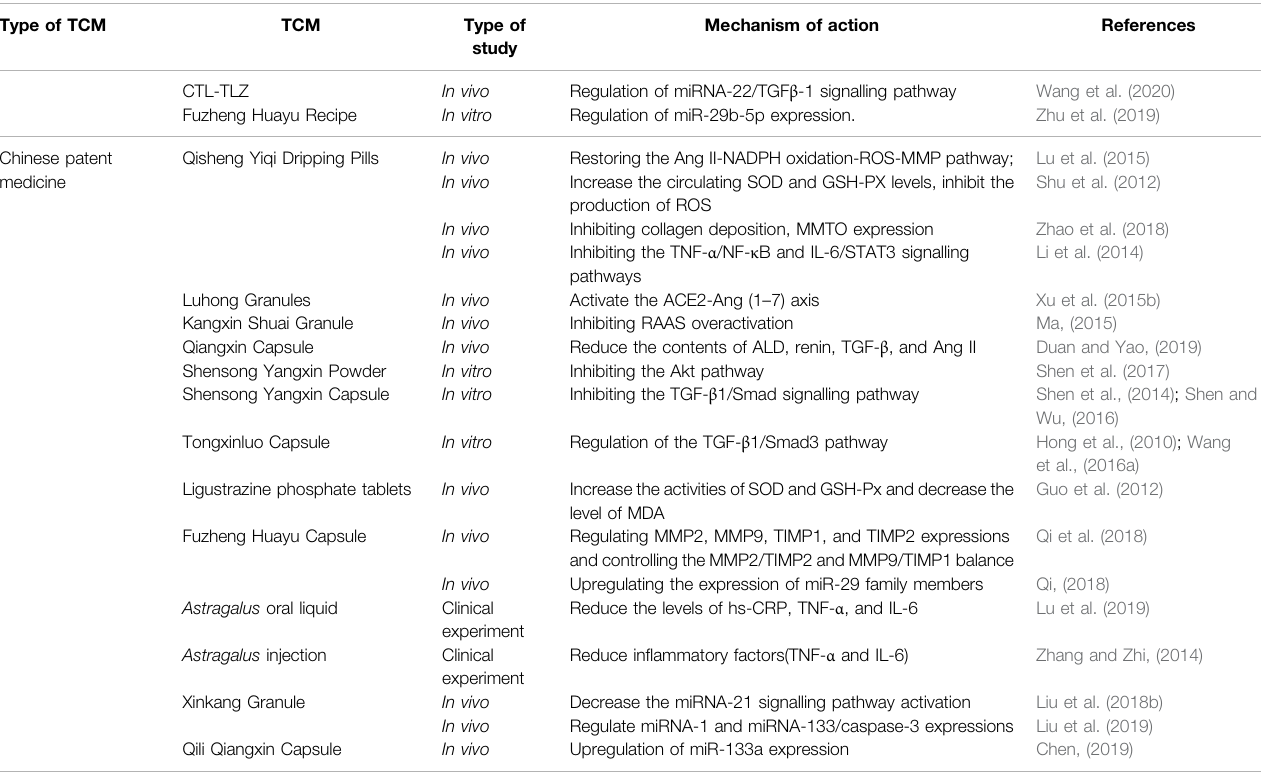
TABLE 2 | ( Continued ) The mechanism of TCM in the treatment of myocardial fi